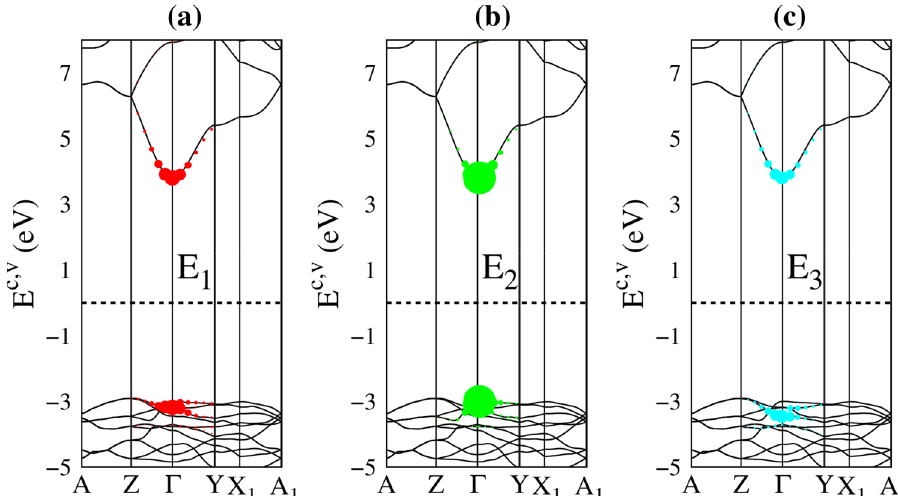
Figure 6. The amplitude of ( a ) the first, ( b ) second and ( c ) third excitons are plotted as fat-band styles. The radii of circles represent the contribution of electron–hole pair at that k-point to the i th exciton wave function, the solid black lines in the background are the corresponding G 0 W 0 quasi-particle band structures, the dash line represents the Fermi